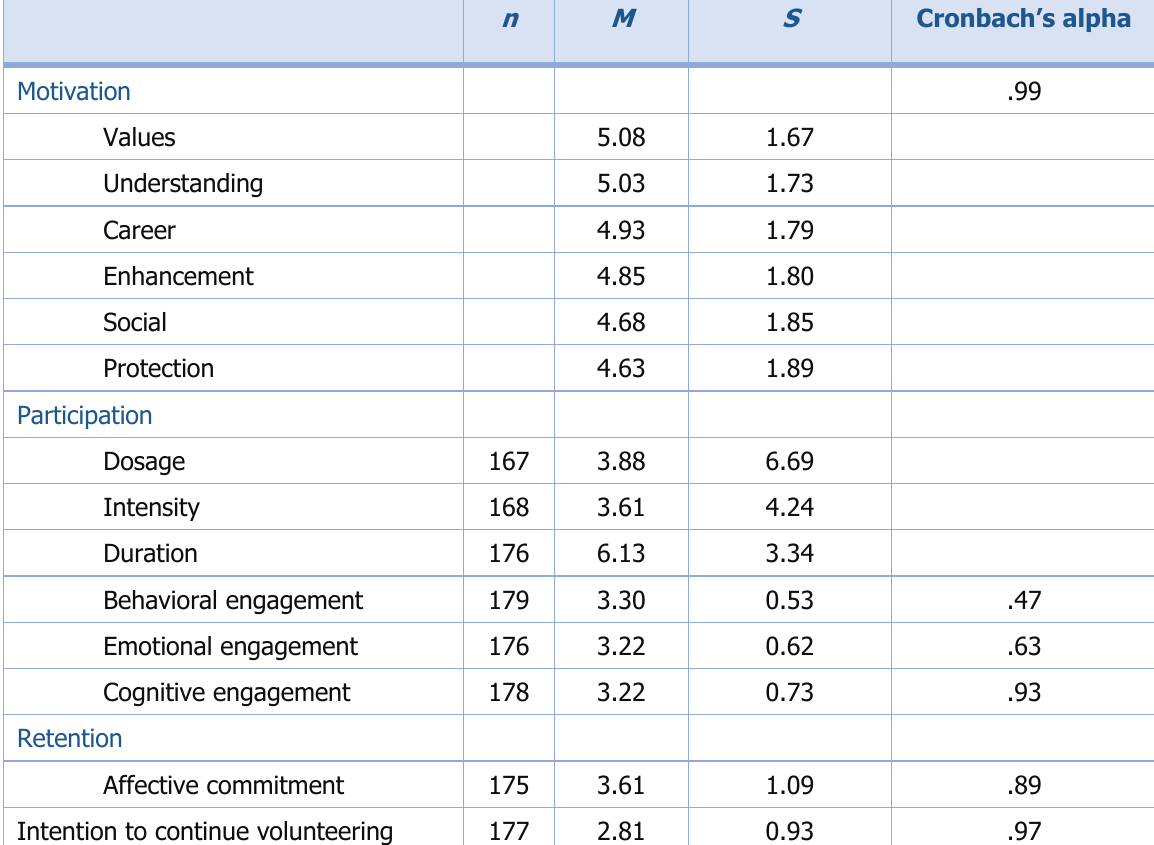
Table 2: Descriptive Statistics for Motivation, Participation and Retention Measures n M S Cronbach’s alpha